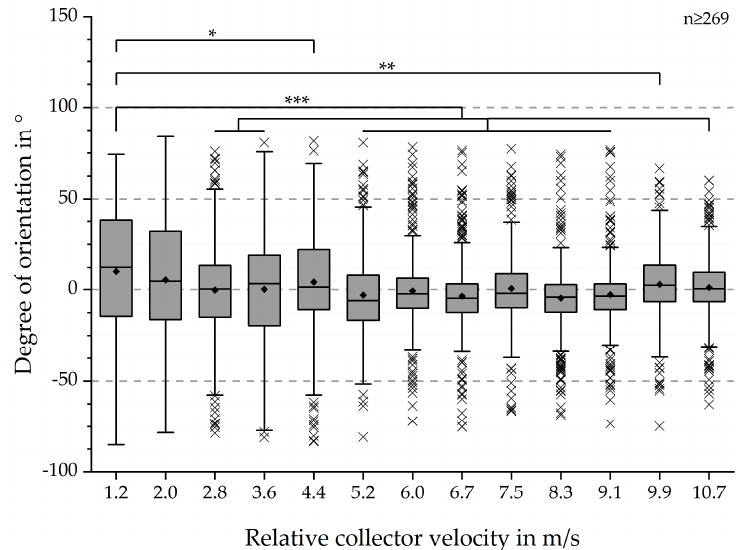
Figure 3. Boxplots of the degree of fibre orientation in ° for each of the 13 relative collector velocities. The resulting boxplots, including outliers, showed a trend of decreasing IQR with increasing relative collector velocity. This trend continued until 8.3 and 9.1 m/s, after which it reversed. Correspondingly, the dispersion followed a similar trend and decreased with increasing relative collector velocity. Based on the QQ-plots, indicating normal distribution, and the recorded values are independent, parametric tests were conducted. Statistical significances for all groups were investigated via one-way repeated measure ANOVAs. Mean differences between the group for 1.2 m/s and the others were analyzsed by the Dunnett post-hoc test and labelled as follows: * ( p < 0.05), ** ( p < 0.01) and *** ( p < 0.001).